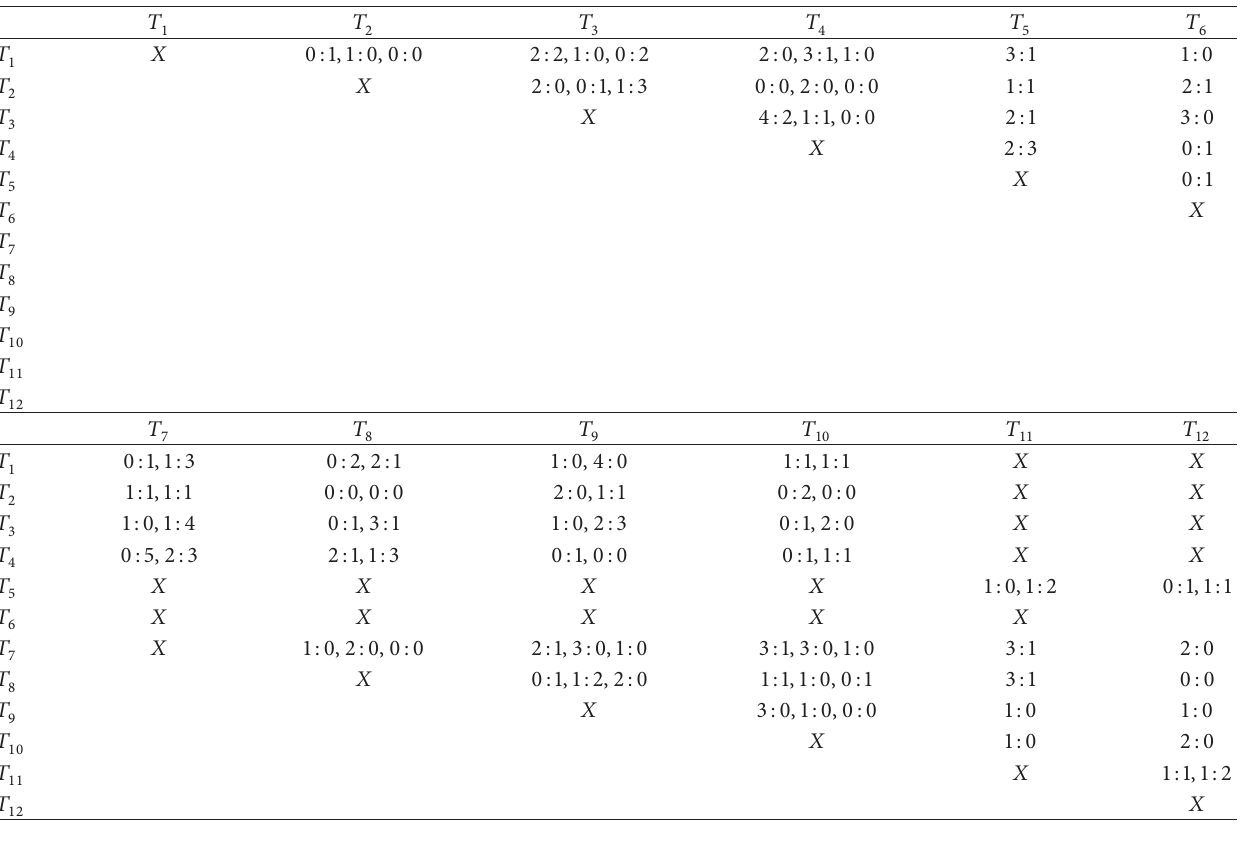
Table 1: Match scores of 12 football